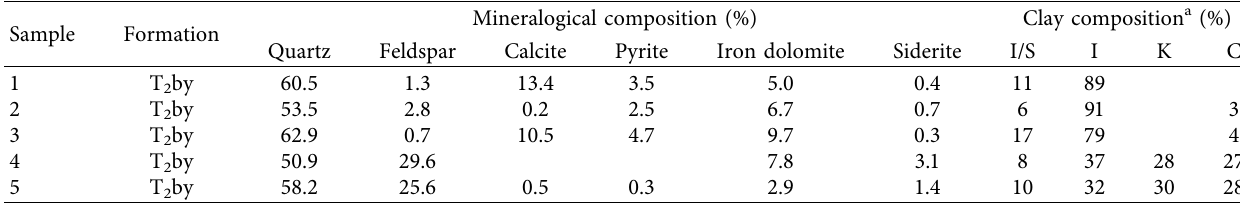
Figure 2: CT scanning process of jointed sandstone. (a) Core box, (b) sandstone sample, (c) nanovoxel-3503E, and (d) CT slice. Table 1: Characteristic parameters and mineral compositions of sandstone